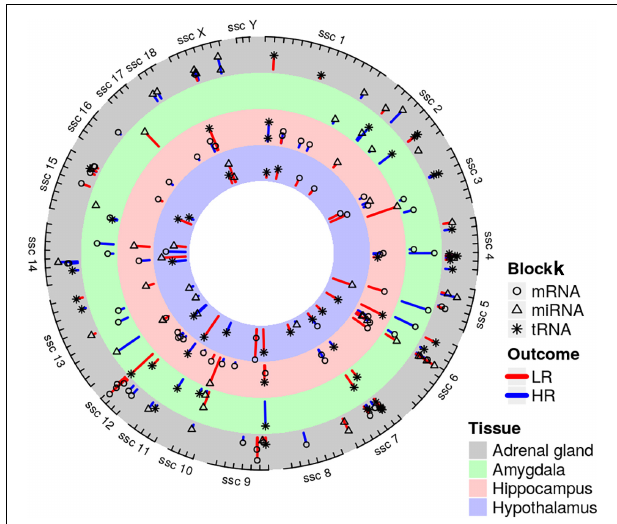
FIGURE 10 | Genomic positions of mRNA (depicted as circularly shaped), miRNA (triangularly shaped) and tRNA (star-shaped) coping behavior related molecules derived by DIABLO analysis of adrenal gland, amygdala, hippocampus and hypothalamus. Molecules were mapped to the Sus scrofa reference genome. Coping behavior haplotype group association is indicated by line color and its length, which illustrates the variation (red highlights the low-reactive (LR) and blue indicates the high-reactive (HR)